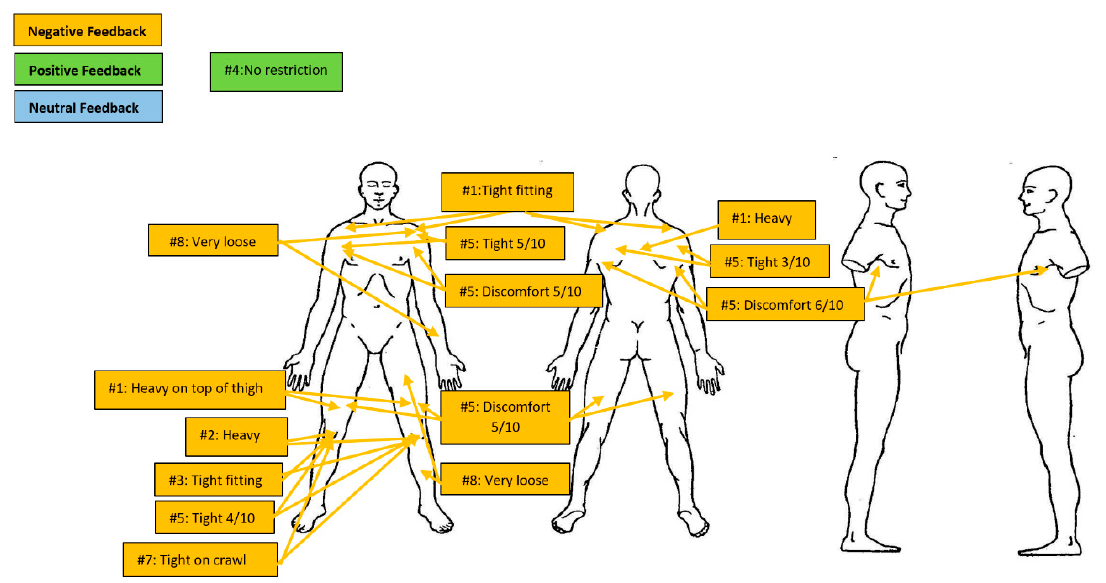
Figure 13. Subjective feedback on Variant 2 (# signifies participant number; scores out of 10 signify discomfort level).